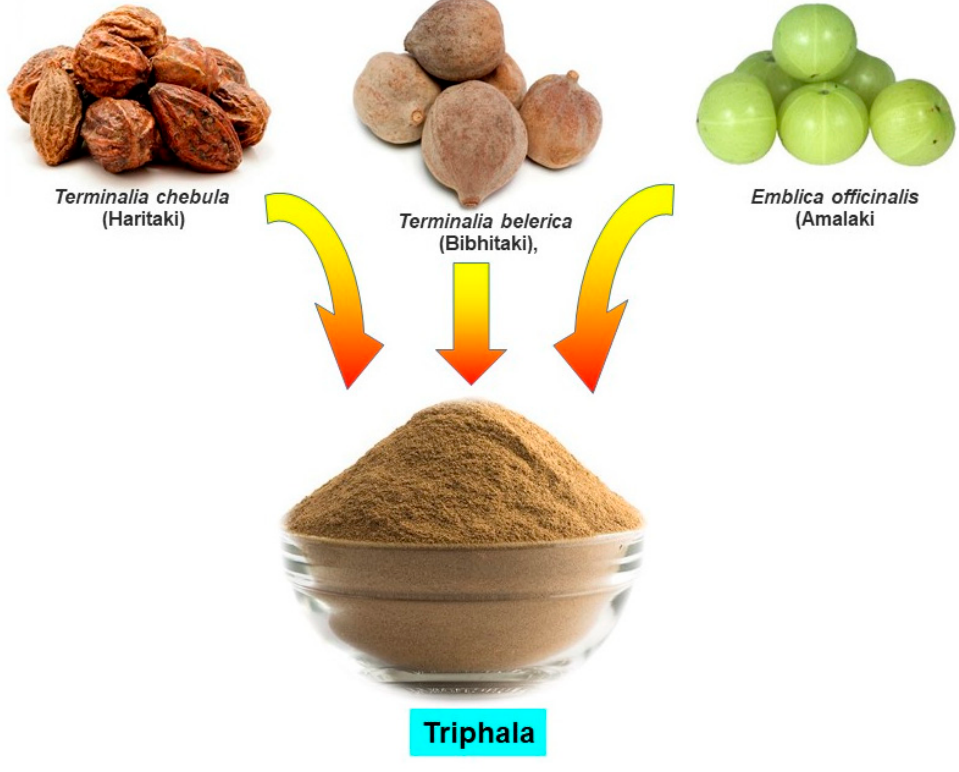
Figure 1. Constituents of Triphala.